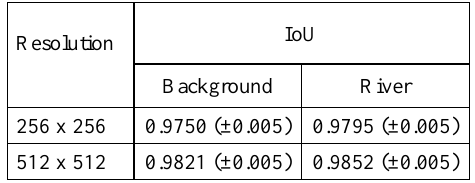
Table 2. Results using IoU in the subset of